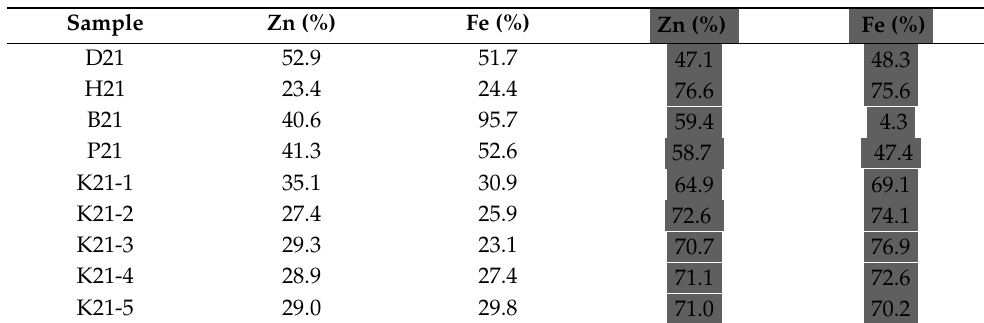
Table 6. Calculation of zinc and iron mass yield at leaching in 20% H 2 SO 4 ; extractable degree ( grey coloring ) results in